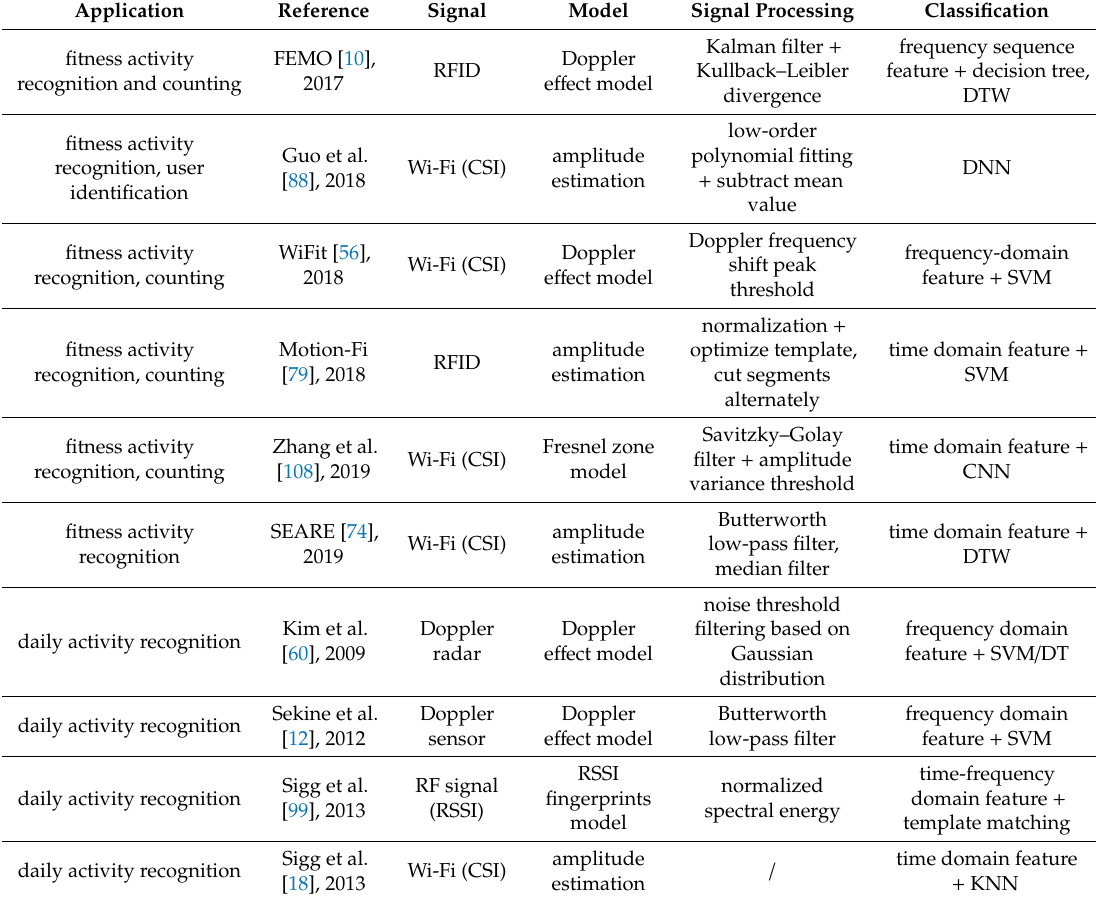
Table 10. Summary of wireless sensing applications: